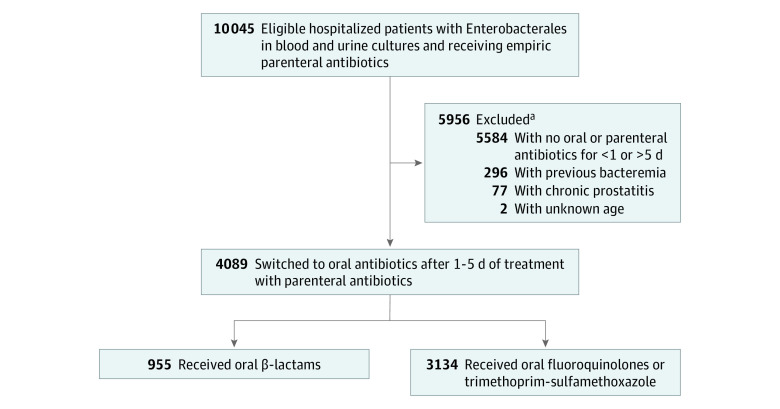
Flow Diagram of Inclusion, Exclusion, and Exposure GroupingaThree patients met multiple exclusion criteria.